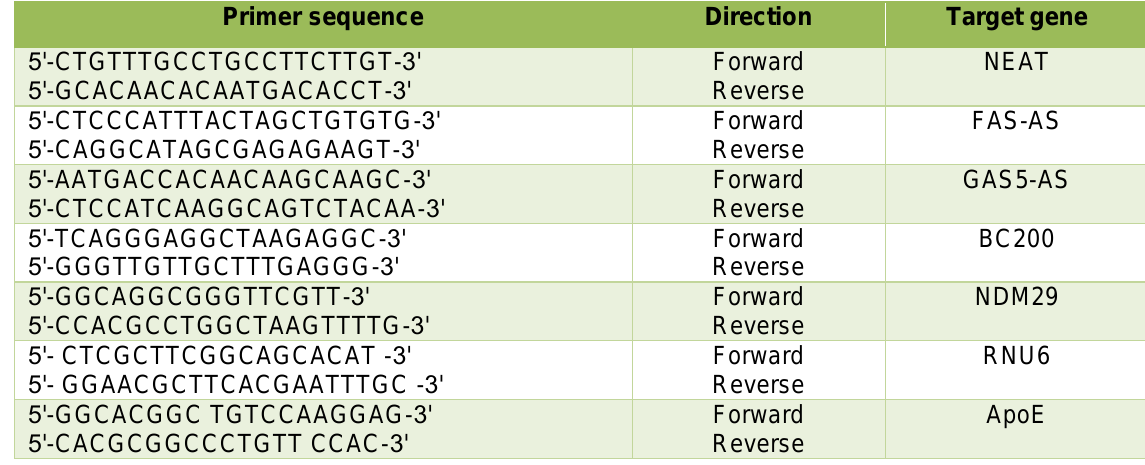
Table 1: Sequences of the primers used in the